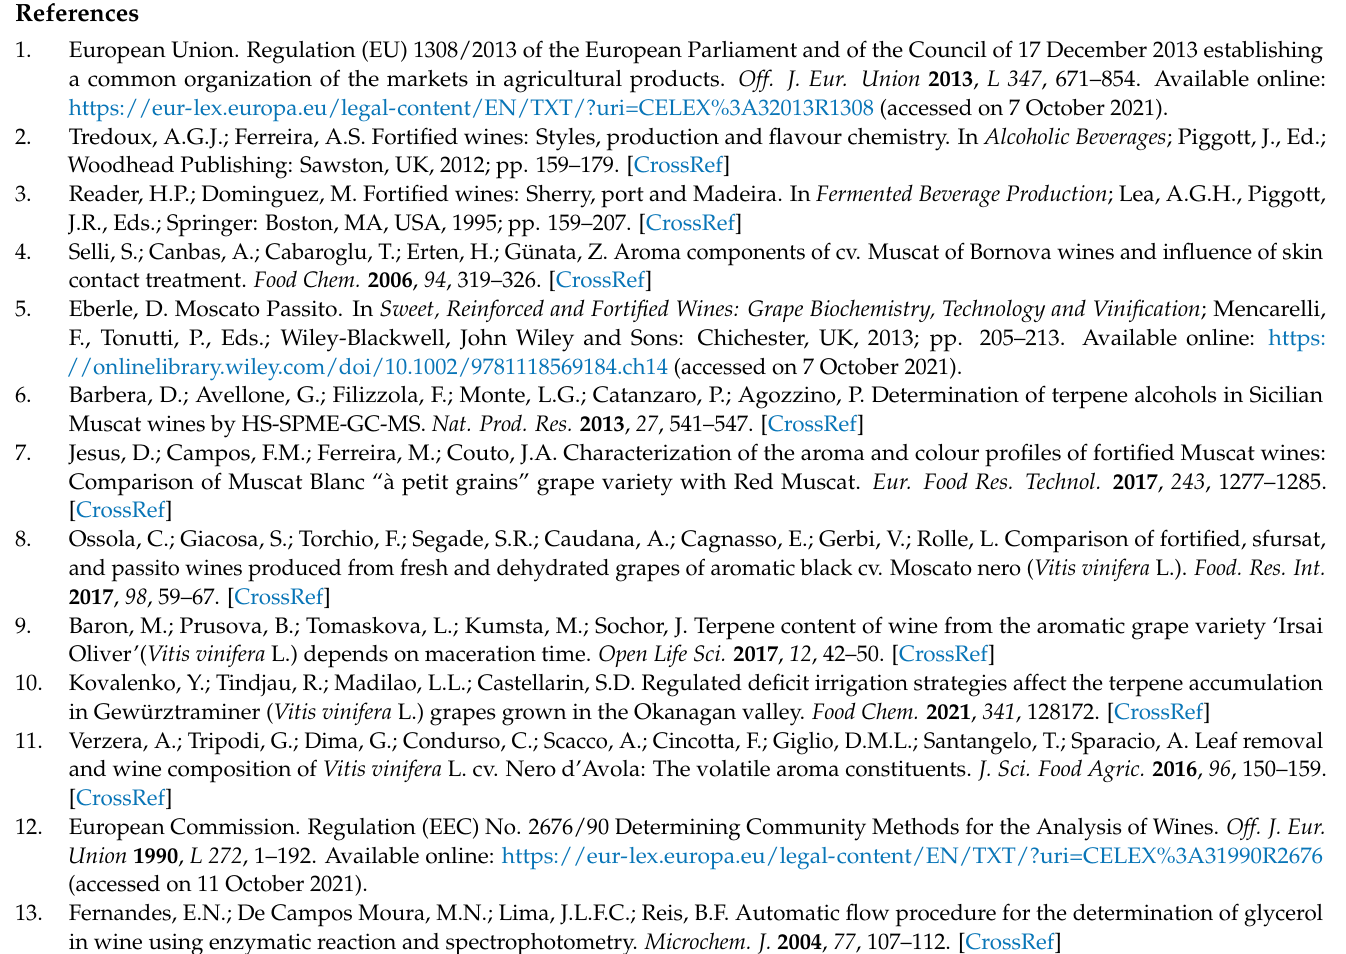
Table S2: Pre-fermentative and fermentative aroma compound identified in Moscato fortified wines, Table S3: Varietal aroma compounds identified in Moscato fortified